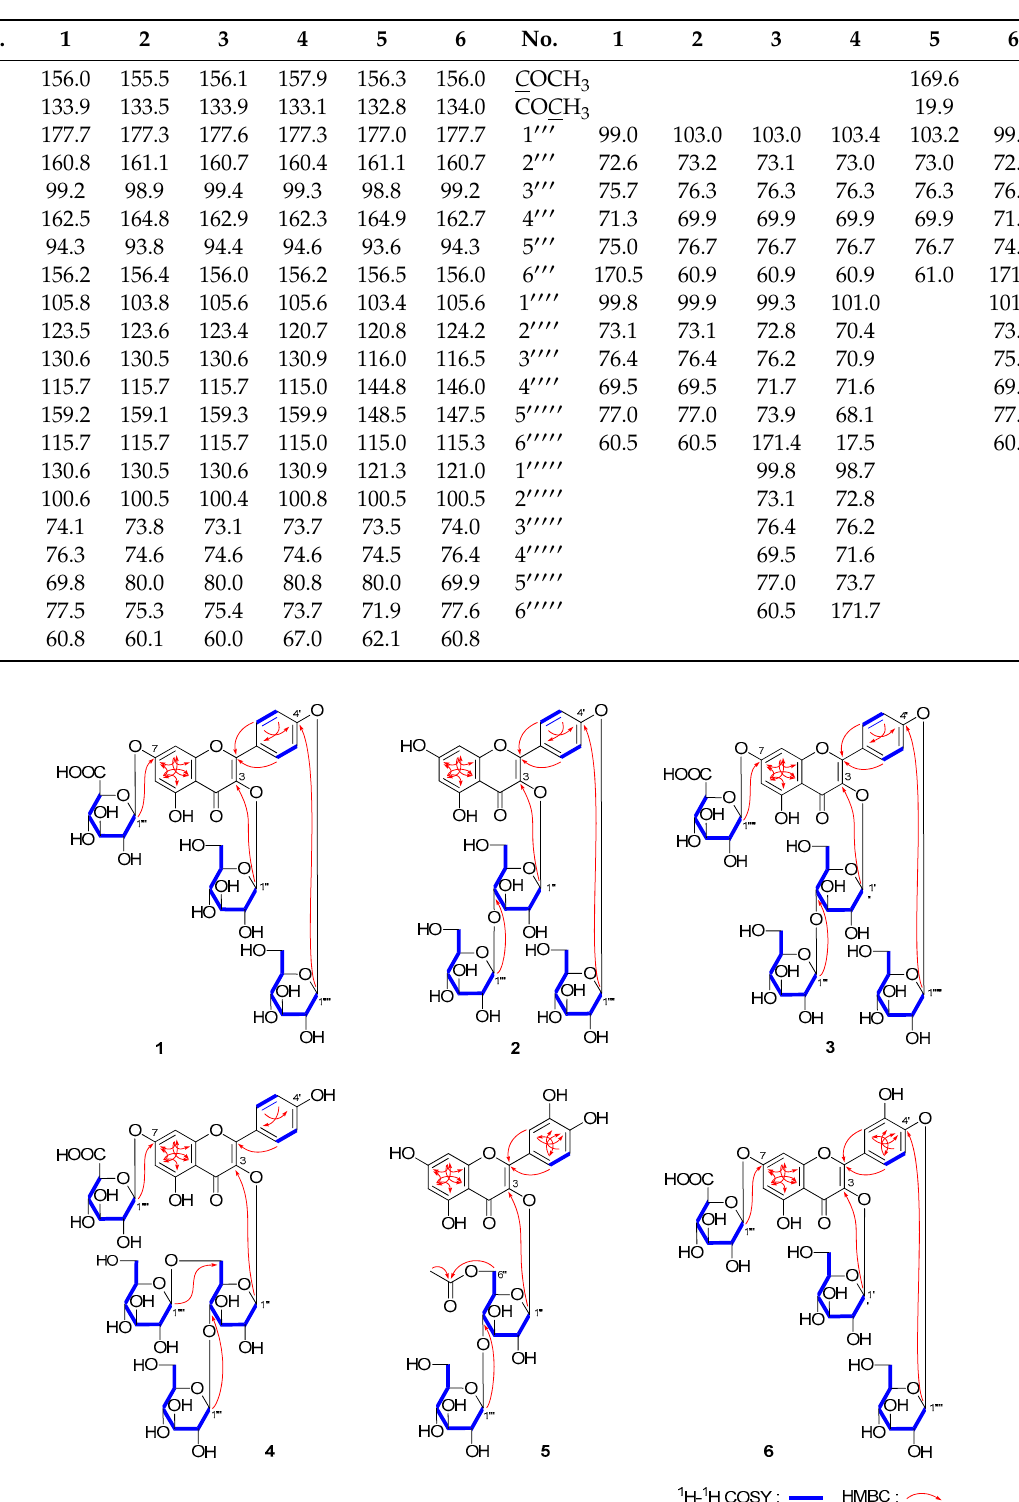
Figure 3. Key 1 H 1 H COSY and HMBC correlations of 1 − 6 . Table 1. 13 C-NMR data for 1 − 6 in DMSO- d 6 .